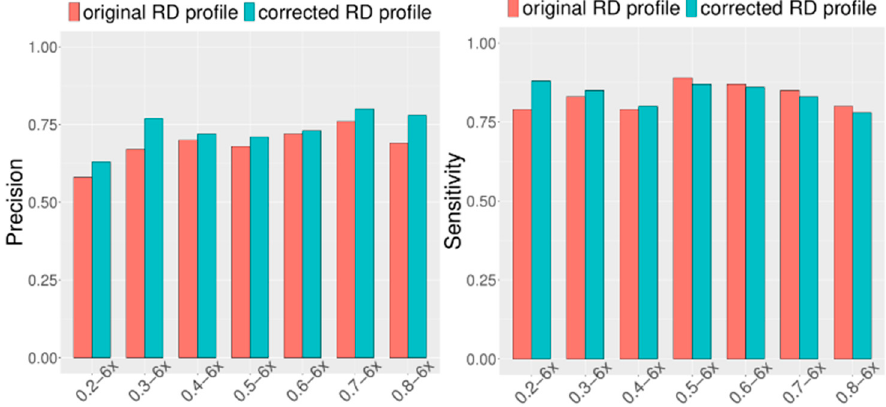
Figure 4. Performance comparisons between the first-round (using original RD profile) and the second-round (using corrected RD profile) CNV detected by the CIRCNV method with respect to sensitivity and precision. The simulation tumor purity ranges from 0.2 to 0.8, and the sequencing coverage depth is 4×.